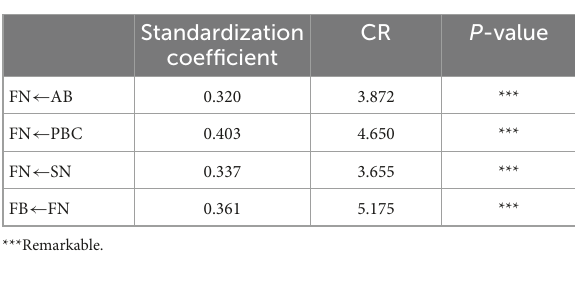
TABLE 9 Path analysis results.